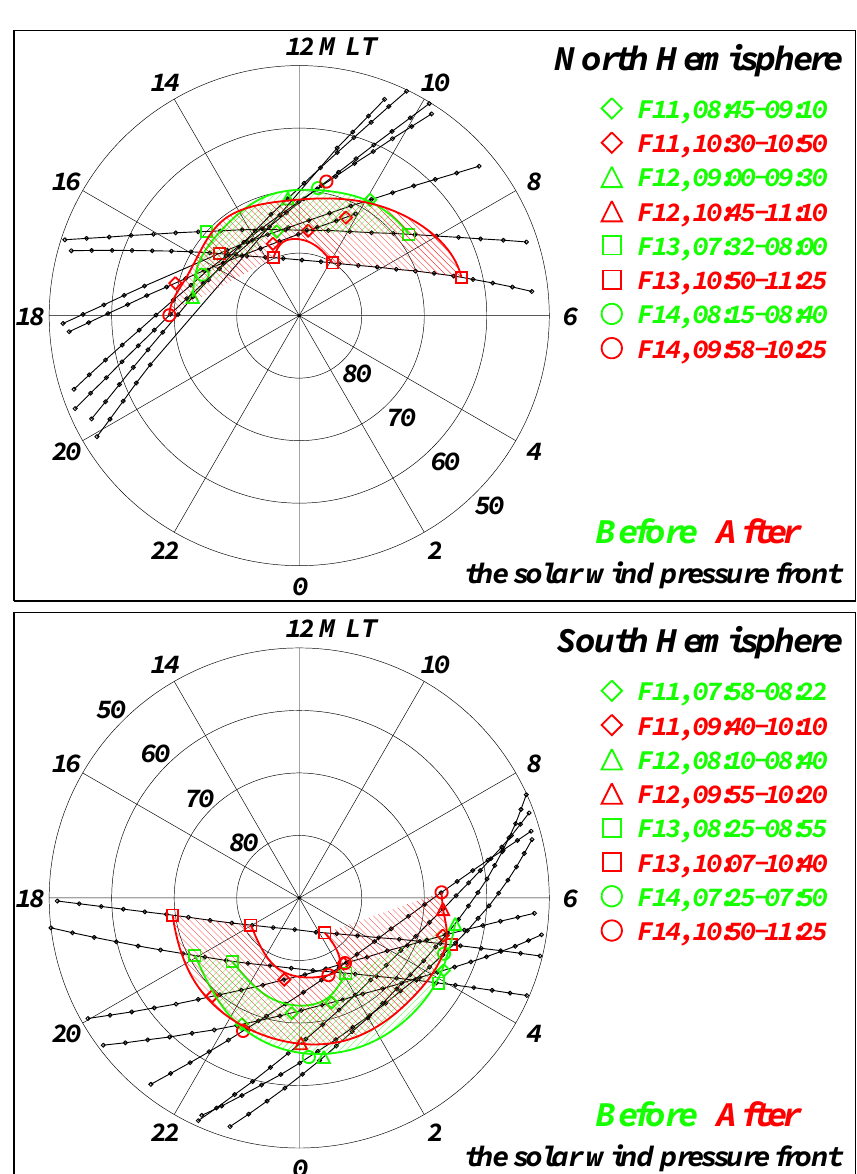
Fig. 6. The same as in Fig. 3 for 30 April 1998, North Hemisphere on the top and South Hemispere on the bottom. The various symbols denoting the boundary crossings by different spacecraft are explained at the legend on the right. A significant poleward expansion of the nightside South Hemispere oval is